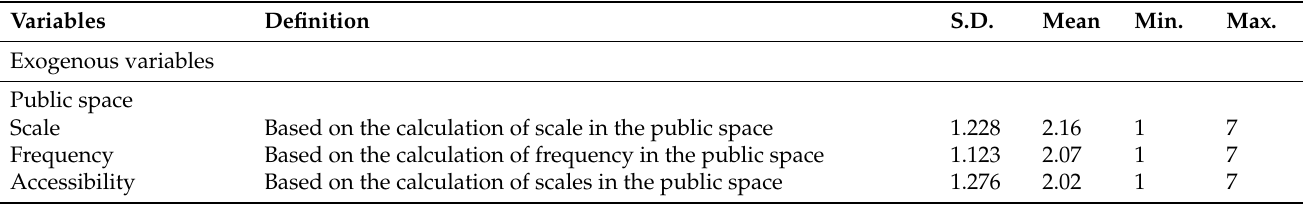
Table 2. Descriptive statistics of observed indicators and exogenous and endogenous